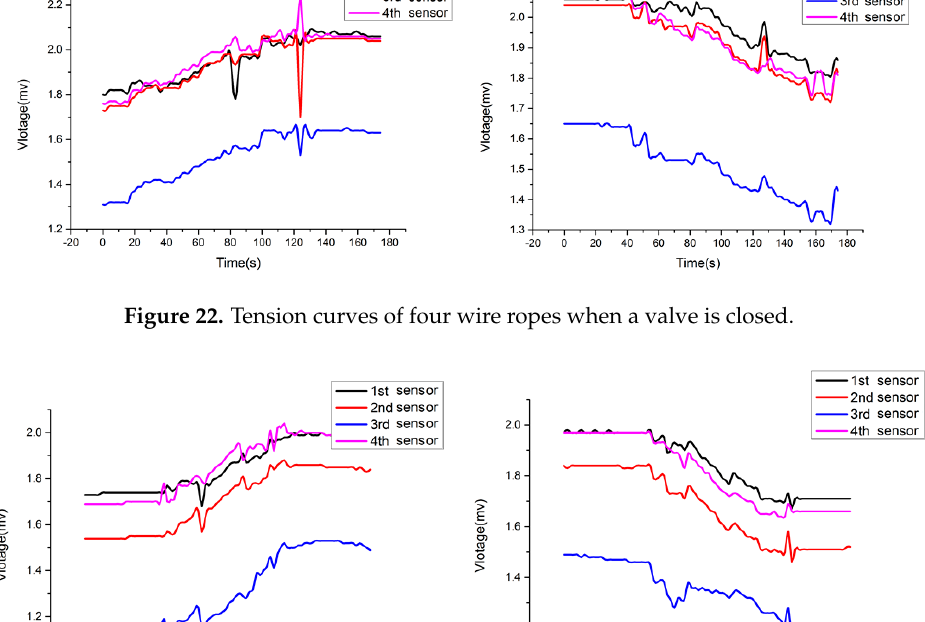
Figure 23. Tension curves of four wire ropes when two valves are closed.